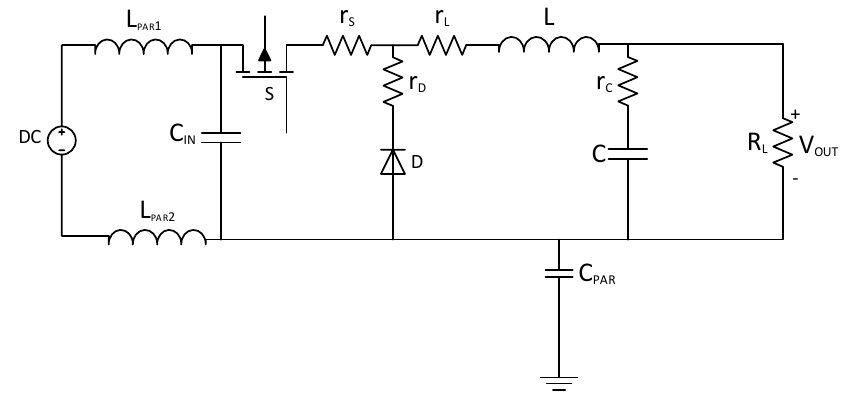
Figure 1. Model of Buck converter including parasitic components.